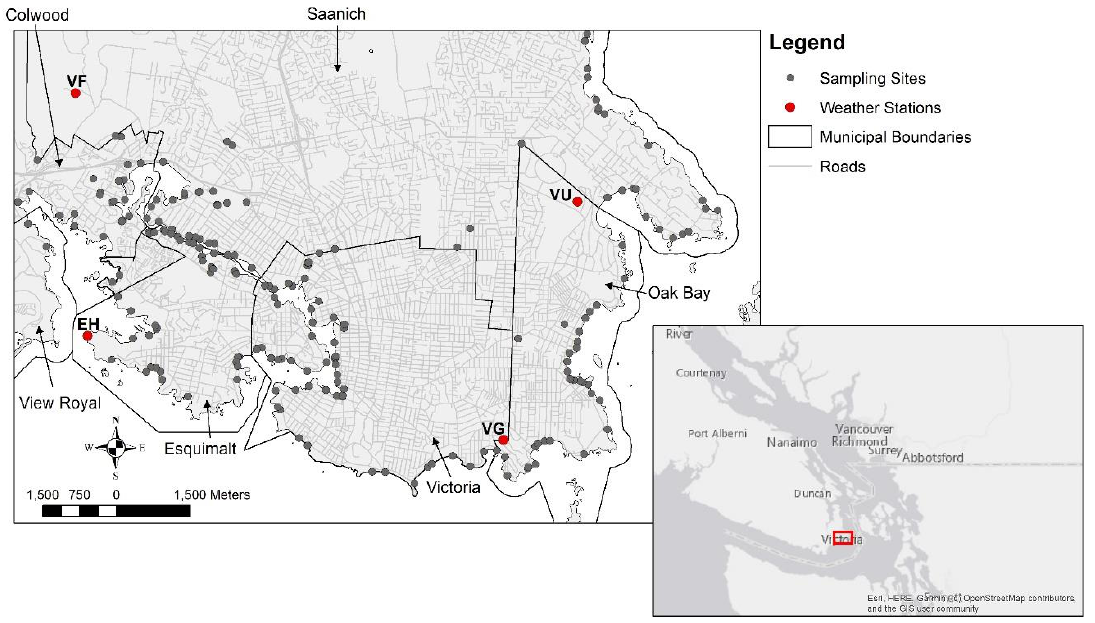
Figure 1. Location of sampling sites and meteorological stations along Nearshore Areas of Southern Vancouver Island. Municipal boundaries are marked with a solid dark line.